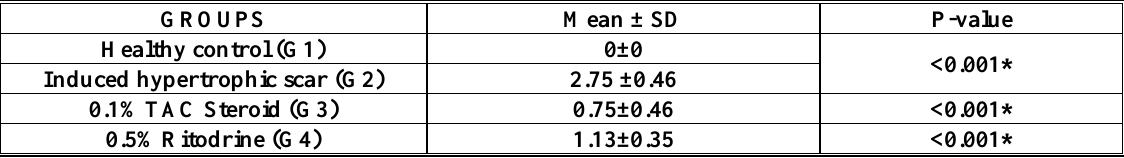
Table3. Mean inflammation score among study groups GROUPS